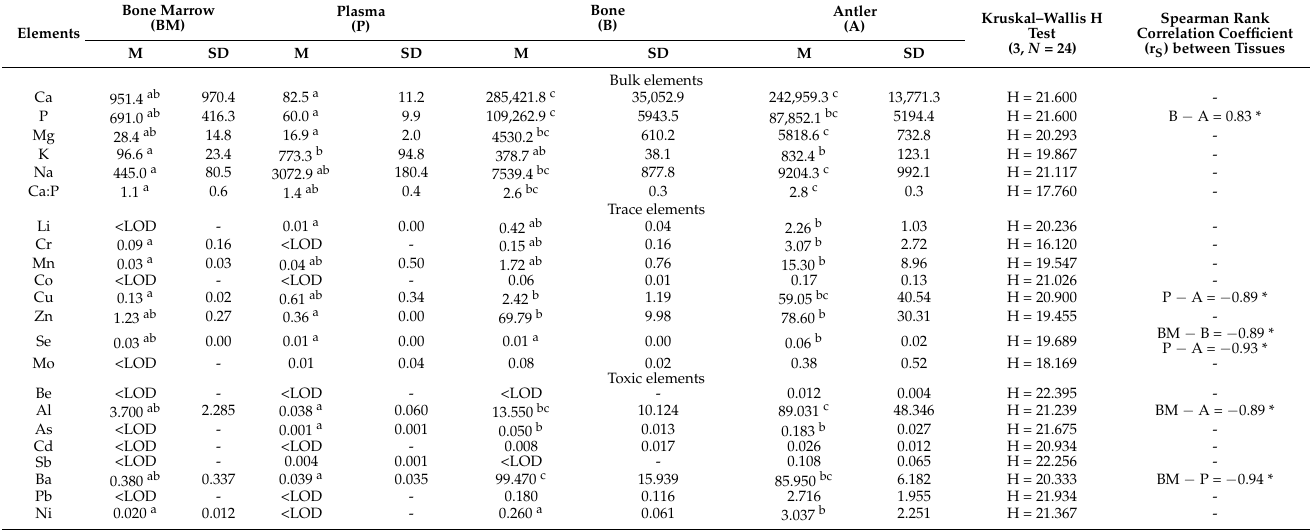
Table 1. Concentration of elements in fresh matter (mg/kg) depending on tissues of fallow